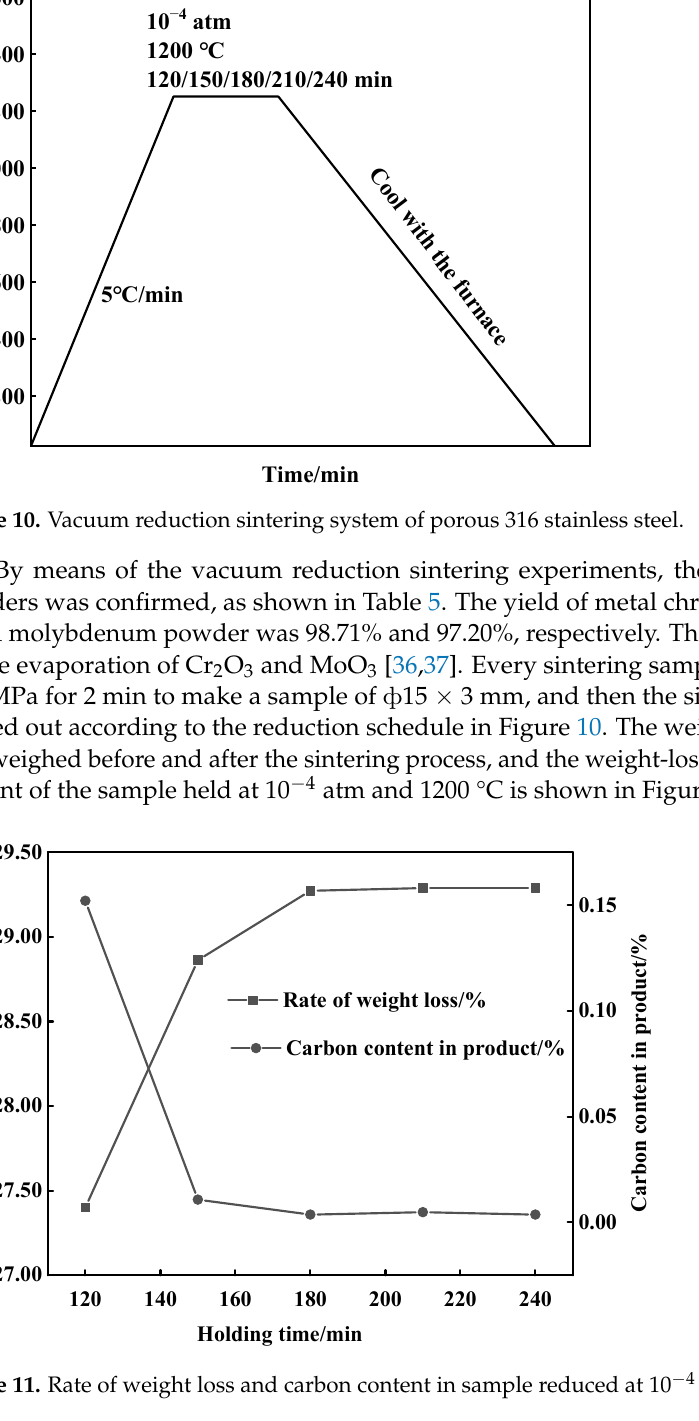
were stable after being held for 180 min under 10 −4 atm and 1200 °C, which were 29.27%